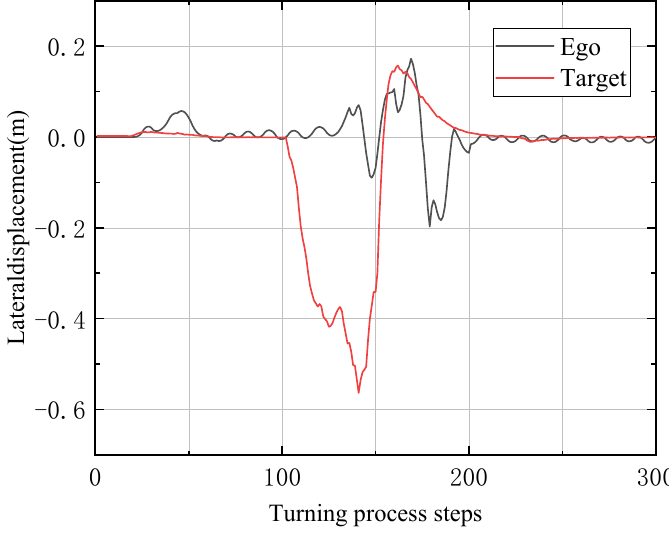
Figure 7. Comparison between the lateral displacement of the ego and target in the turning process.